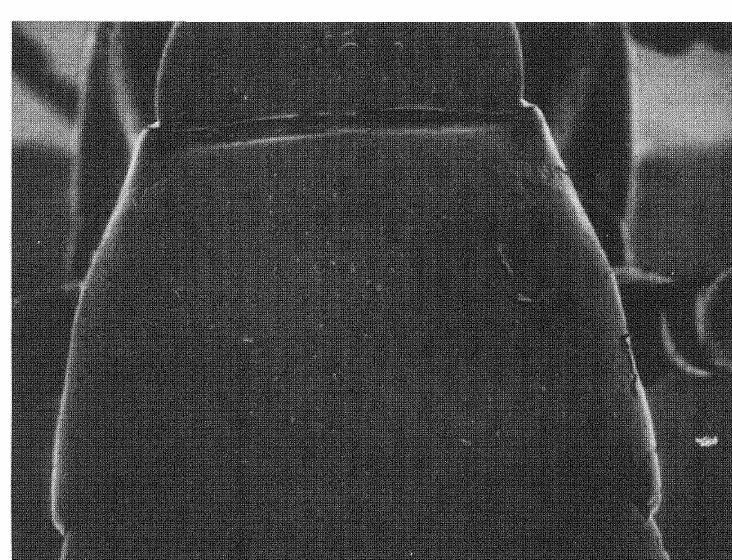
Fig. 19. Cosmiocryptus weyrauchL gastric tergite and adjoining areas in dorsal